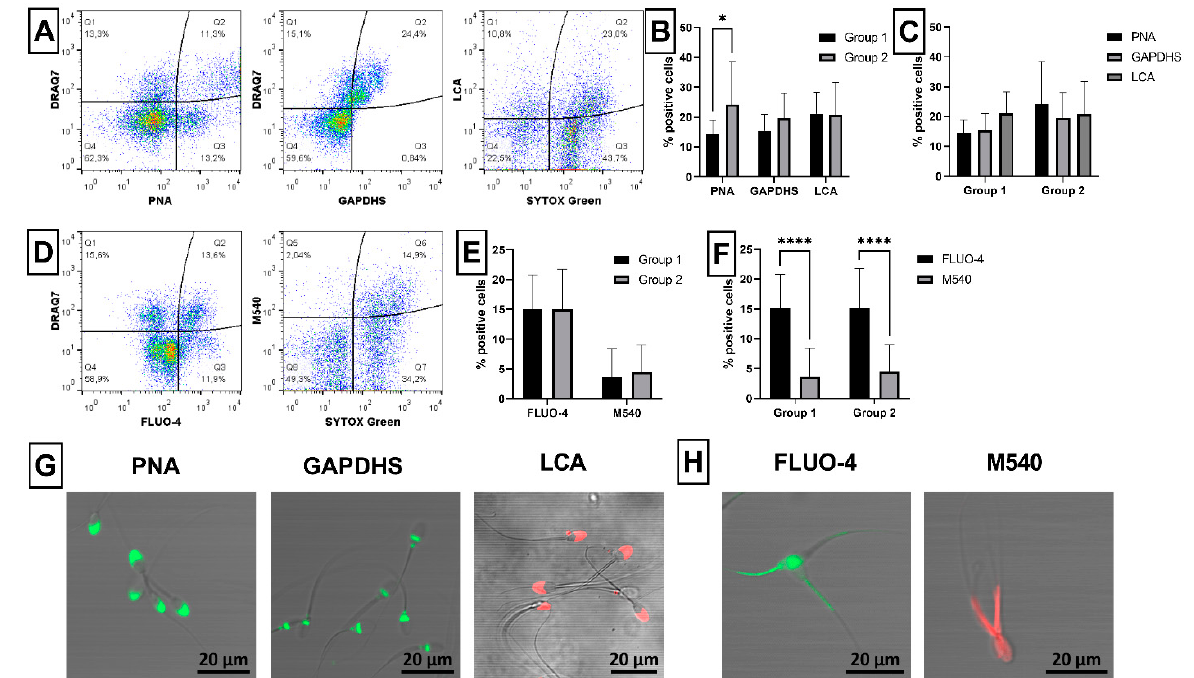
Figure 3. Evaluation of ram sperm acrosome integrity and capacitation status. Illustrative flow-cytometric dot plots showing evaluation strategy of analyzed fluorescent probes. Spermatozoa gated using FSC/SSC dot plot showing dead spermatozoa in far-red FL4 channel (DRAQ7 + ) or green FL1 channel (SYTOX Green) and acrosome-damaged spermatozoa in green FL1 channel (PNA and GAPDHS) or red FL3 channel (LCA) were divided into four quadrants (Q) according to fluorescent signals ( A ). Graph showing comparison of acrosome-damaged spermatozoa detected using PNA (Q2: PNA + /DRAQ7 + and Q3: PNA + /DRAQ7 − ), GAPDHS (Q2: GAPDHS + /DRAQ7 + and Q3: GAPDHS + /DRAQ7 − ), and LCA (Q1: LCA + /SYTOX Green − and Q2: LCA + /SYTOX Green + ) in Group 1 and Group 2 ( B ). Graph comparing proportion of acrosome-damaged spermatozoa detected using three different fluorescent probes (PNA, GAPDHS and LCA) within each group ( C ). Illustrative flow-cytometric dot plots showing evaluation strategy of analyzed fluorescent probes. Spermatozoa gated using FSC/SSC dot plot showing dead spermatozoa in far-red FL4 channel (DRAQ7 + ) or FL1 channel (SYTOX Green) and capacitated spermatozoa in green FL1 channel (FLUO-4) or red FL3 channel (M540) were divided into four quadrants (Q) according to fluorescent signals ( D ). Graph showing comparison of capacitated spermatozoa detected using FLUO-4 (Q2: FLUO-4 + /DRAQ7 + and Q3: FLUO-4 + /DRAQ7 − ) and M540 (Q5: M540 + /SYTOX Green − and Q2: M540 + /SYTOX Green + ) in Group 1 and Group 2 ( E ). Graph comparing proportion of capacitated spermatozoa detected using two different fluorescent probes (FLUO-4 and M540) within each group ( F ). Illustrative images from confocal microscopy (Zeiss LSM 700; magnification at 200×, scale bar = 20 µm) showing the staining pattern of ram spermatozoa with acrosomal fluorescent probes PNA (green) and LCA (red) specifically stained sperm acrosome, while GAPDHS antibody (green) labeled post-acrosomal region of sperm heads ( G ), and probes for sperm capacitation FLUO-4 (green) and M540 (red) labeled sperm heads and tails ( H ). Group 1—semen samples with sperm viability over 60%, Group 2—semen samples with sperm viability under 60%. The data are expressed as the means ± SD; difference is statistically significant at * p < 0.05 and **** p < 0.0001.